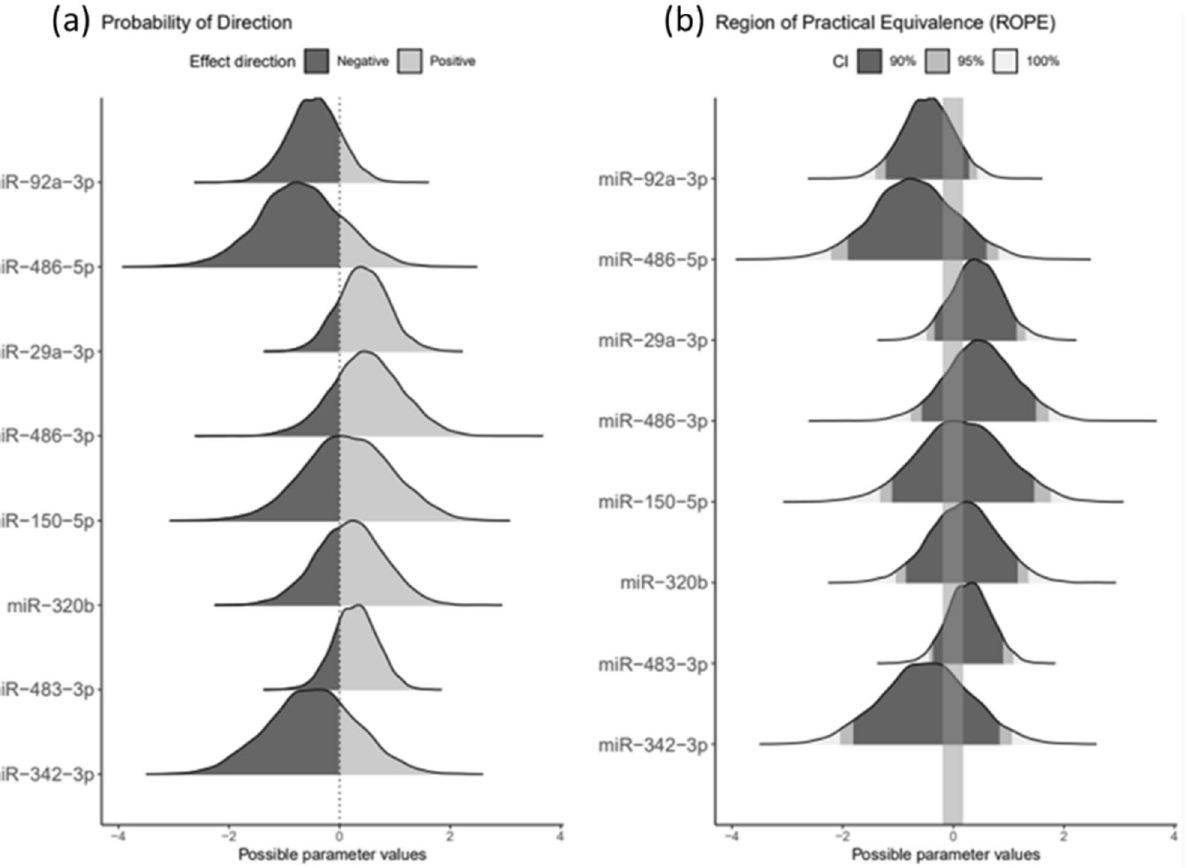
Figure 1. Probability of direction (PD) and Region of Practical Equivalence (ROPE) for each miRNA. ( a ) PD shows the estimation of direction for each biomarker, showing a protective AD effect for those with negative direction and risk AD effect for those with positive direction. Polygons show the density summary of the posterior draws and coloured given the estimated direction (positive or negative) of the effect parameter. The proportion of the polygon that does not include zero is a statement about probability of the proposed direction of effect. ( b ) ROPE represents the area of null equivalence that is the percentage with none direction (positive or negative). Effects given a full ROPE based on a 100%, 95% and 90% highest posterior density interval. The proportion of the polygon that does not include zero is a statement about the significance of